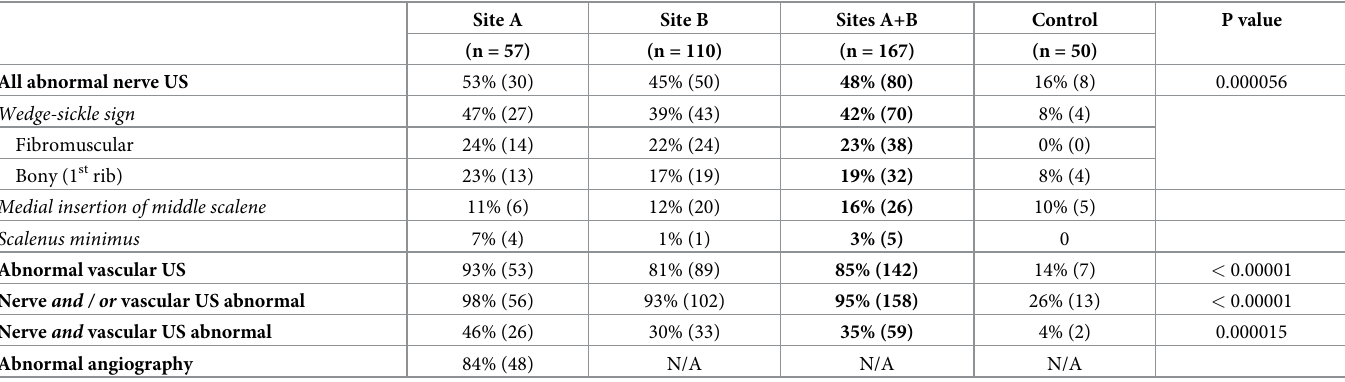
Table 2. Summary of ultrasonographic and angiographic findings.